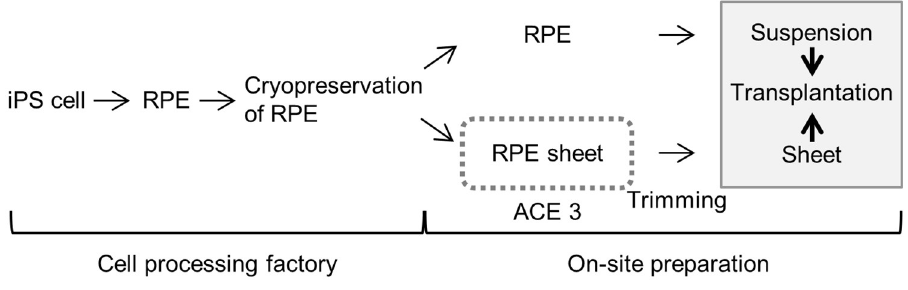
Fig 5. Perspective and potential applications of the present